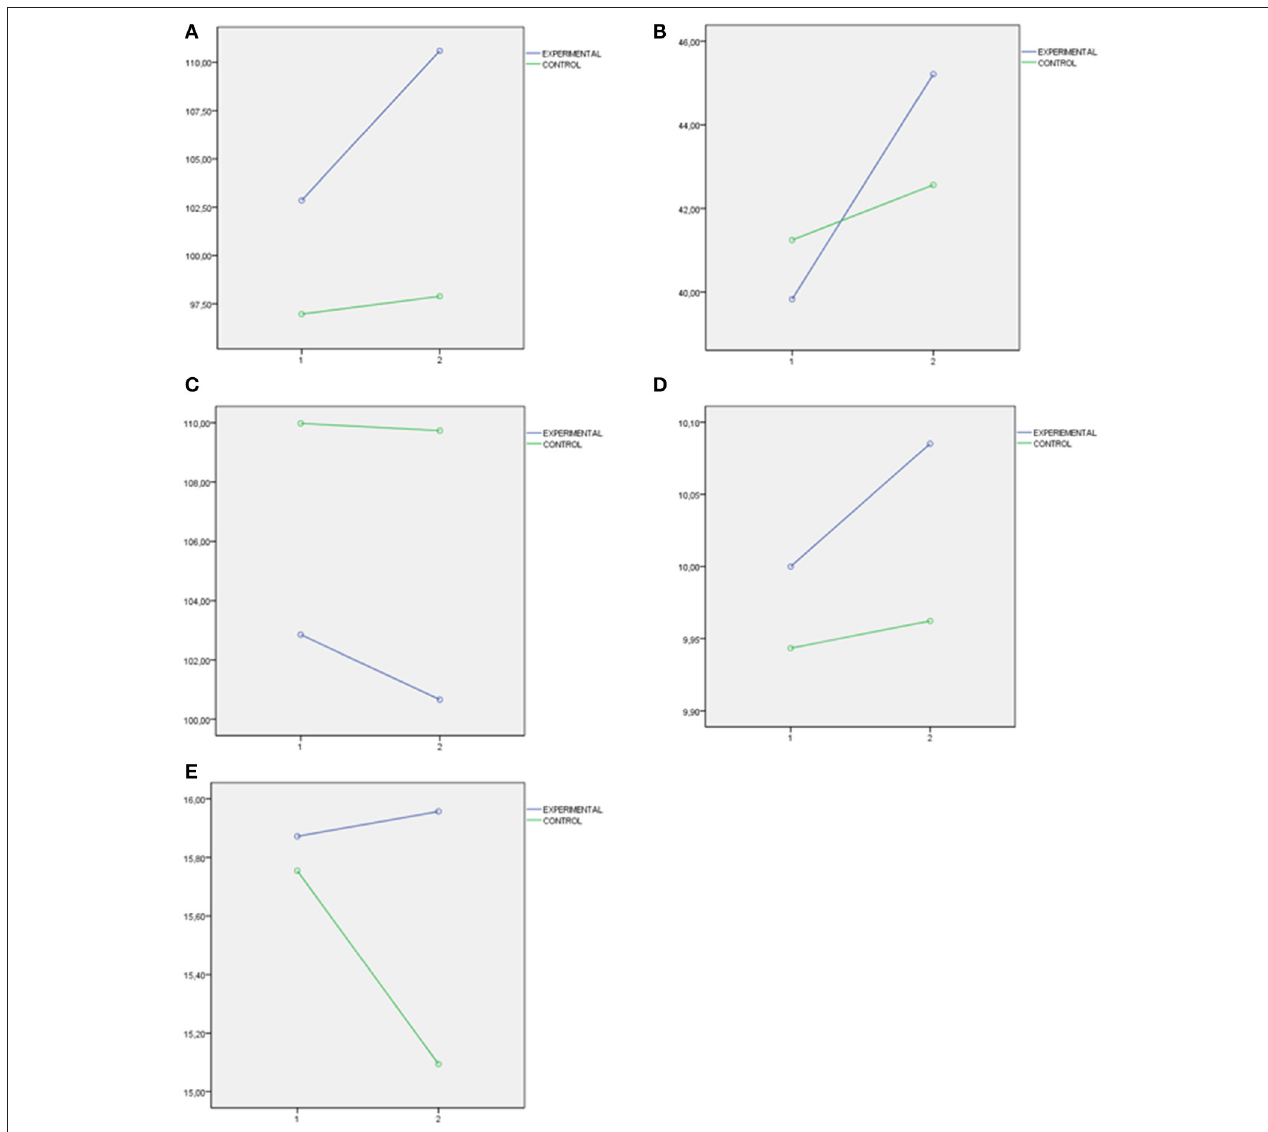
FIGURE 2 | (A) MESSY Total Scale as a representation of the significant difference obtained in the set of factor of EI measure with youngsters’ social skills measure with Matson Evaluation of Social Skills. (B) Aggressiveness/antisocial behavior MESSY. (C) Social skills/assertiveness MESSY. (D) Conceit/haughtiness MESSY. (E) Loneliness/social anxiety